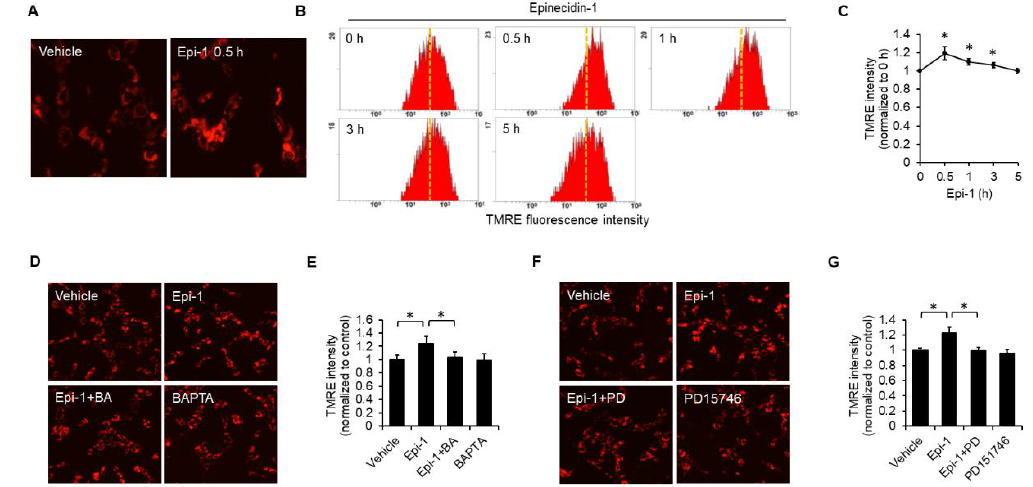
Figure 4. Calcium-dependent calpain activation plays an essential role in epi-1-induced mitochondrial hyperpolarization. Cells were treated with epi-1 for the indicated times, followed by incubation with TMRE (100 nM) for 15 min. Fluorescence intensity of TMRE was assessed by fluorescence microscopy ( A ) and flow cytometry ( B , C ). Dotted line: Basal TMRE levels. Cells were pretreated with BAPTA (10 µ M) for 1 h, followed by epi-1 for an additional 0.5 h. TMRE intensity was assessed by fluorescence microscopy ( D ) and flow cytometry ( E ). Cells were preincubated with PD151746 (PD) for 1 h, followed by epi-1 for an additional 0.5 h. TMRE intensity was assessed by fluorescence microscopy ( F ) and flow cytometry ( G ). All fluorescent microscope images were taken under in 20 × magnification. * p < 0.05 was considered